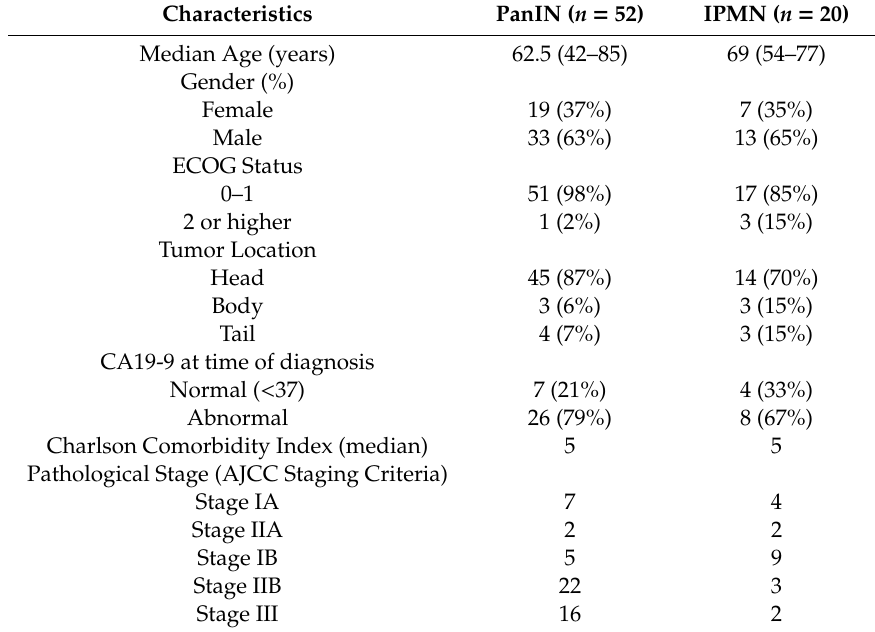
Table 1. Baseline Characteristics.